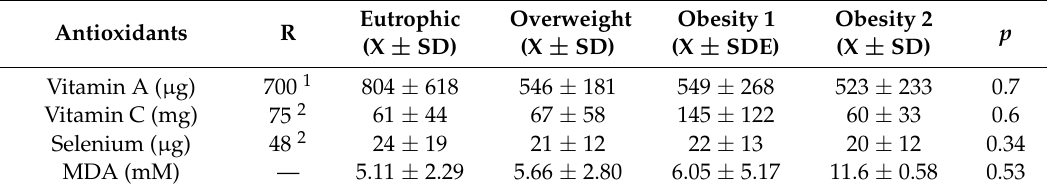
Table 4. Comparison of the consumption of antioxidants and the plasmatic level of malondialdehyde in each BMI